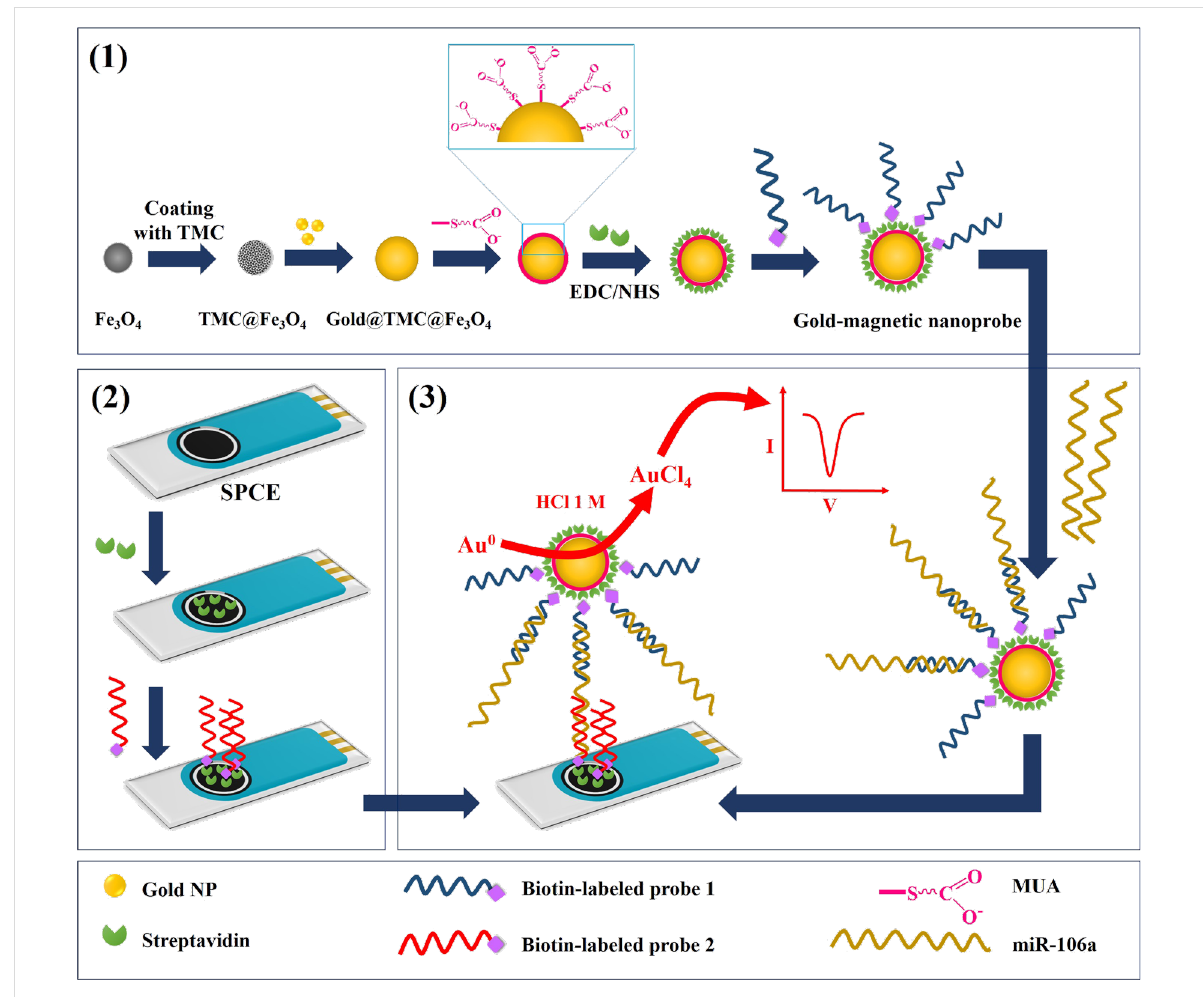
Figure 1: Schematic of the principal mechanism for miR-106a detection by the nanobiosensor. (1) Preparation the nanoprobe; (2) modification of the electrode; and (3) hybridization steps (TMC = N -trimethylchitosan).